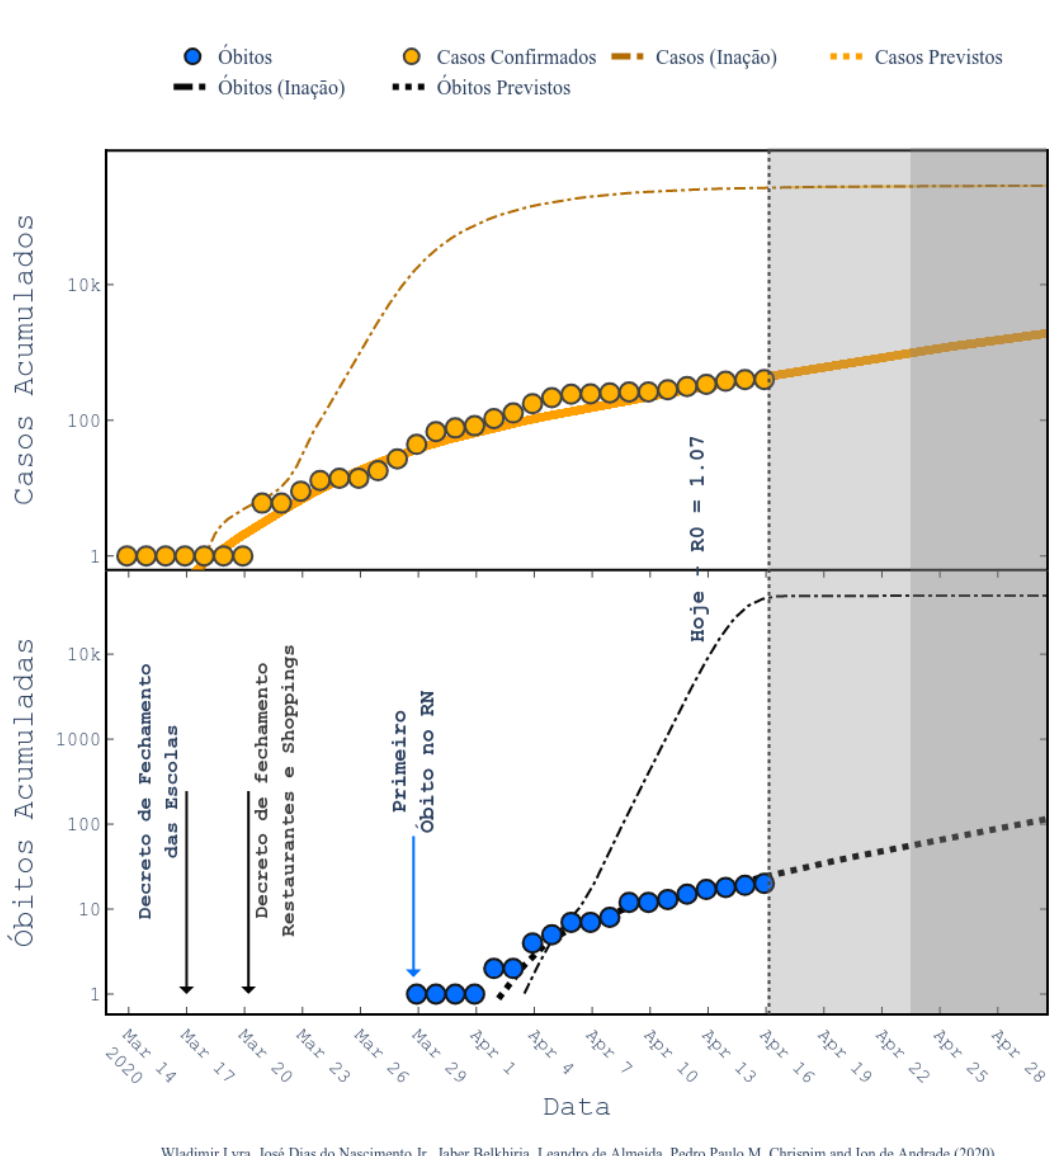
Figure 6. Projections for Rio Grande do Norte state (at the northeast of Brazil) [34]. Figure printed out from the web application running at http://astro.dfte.ufrn.br/html/Cliente/COVID19.php. Acessed on 4